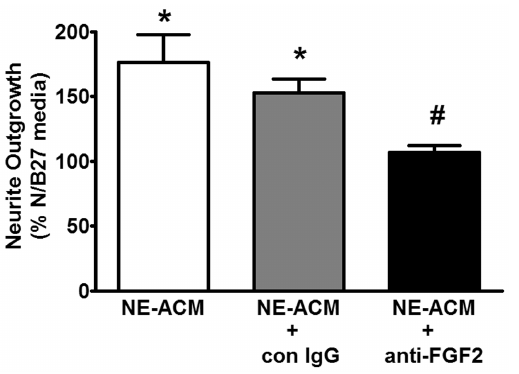
Figure 8. Neutralizing antibody to FGF-2 blocks neurite- promoting effects of astrocyte conditioned media from noradrenergically stimulated astrocytes. Astrocytes were incu- bated in N/B27 media to which norepinephrine (NE; 10 uM) was added just prior to 6 hr incubation. After 6 hr, conditioned media (NE-ACM) was collected and concentrated 10-fold by ultrafiltration through a 7000 MW cutoff membrane. The conditioned media was incubated for 30 min at room temperature in the presence of anti-FGF-2 neutralizing antibody (2.5 ug/ml goat polyclonal from R&D systems) or control IgG (2.5 ug/ml goat IgG) prior to applying to neuronal cultures on coverslips. Following 24 hr incubation neurons on coverslips were fixed and stained for MAP2 and analyzed for neurite outgrowth as described in Methods. Data were analyzed by one-way ANOVA followed by Student-Newman-Keuls comparisons. Data represent the mean 6 SEM of 3 independent observations. *, P , 0.05 as compared to unconditioned N/B27 media; # , P , 0.05 as compared to NE-ACM or NE-ACM + con IgG.